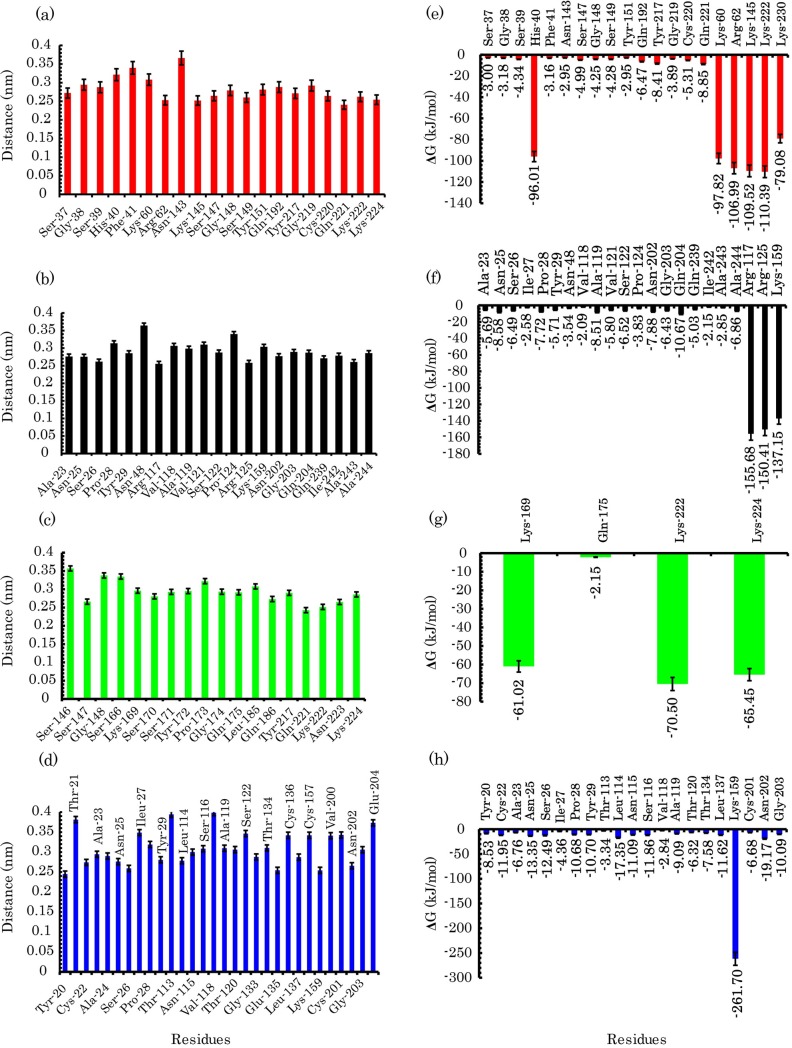
Adsorption process of the enzyme on the surface of COOH-f-DWCNT.(a) to (d) The minimum distance between residues and COOH-f-DWCNT in system 1, system 2, system 3 and system 4, respectively. (e) to (h) the energy residues with value of binding energy < -2 kJ.mol−1 in system 1, system 2, system 3 and system 4, respectively.